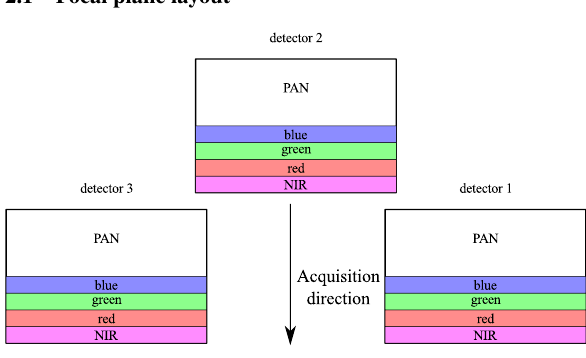
Figure 1: Skysat-1 focal plane, as projected to the ground. Skysat-1&2 use 3 CMOS frame detectors with a size of 2560x2160 pixels and a pixel size of 6.5 µm . The upper half of the detector is used for panchromatic capture, the lower half is divided into 4 stripes covered with blue, green, red and near infra-red color fil- ters. A schematic of the focal plane layout is shown in Fig. 1. The native resolution at nadir of the SkySat-1 and Skysat-2 is around 1.1 m. Further satellites will be placed in lower orbits, leading to increased image resolution. The Raw Video and Frame products contains both a physical camera model and a RPC for each individual frame. The interior orientation is given by the location (X,Y,Z) and tilts the CMOS detector planes with respect to the projection center of the tele- scope. The unconventional interior orientation with 3D rotation of the focal plane with respect to the telescope requires